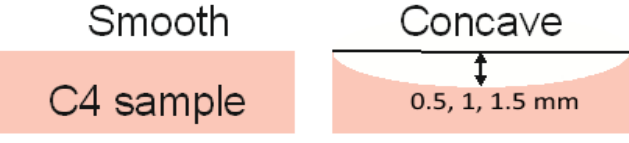
Figure 21. PWM C4 pellet with concave surface